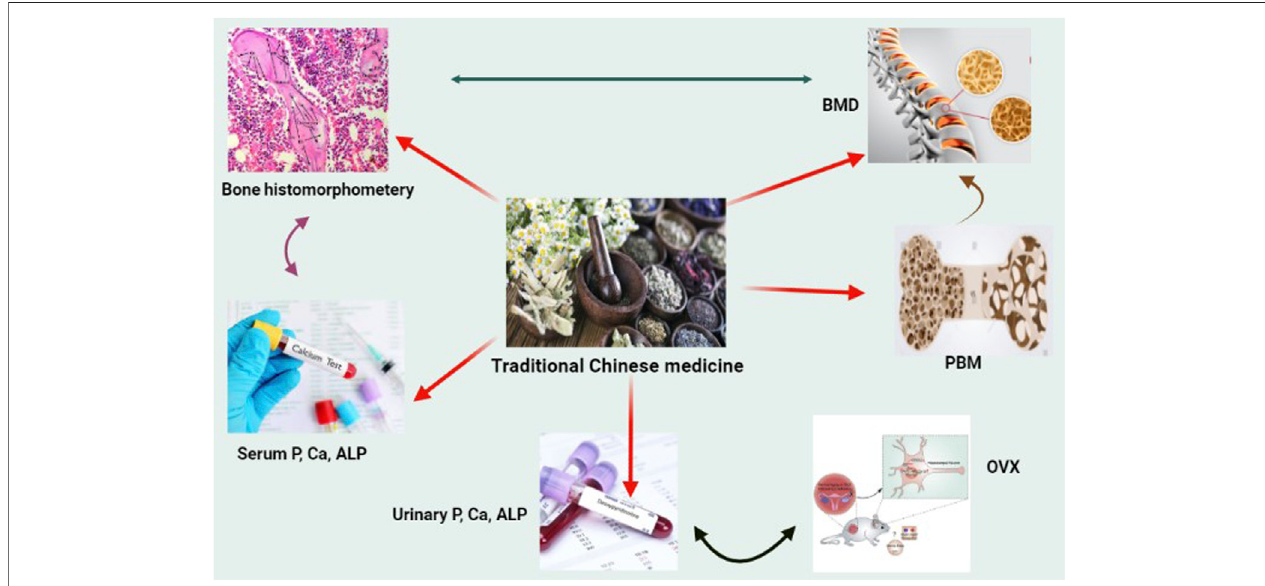
FIGURE 1 | Natural Chinese medicine ’ s therapeutic promise in the treatment of osteoporosis. When faced with the obstacles of oestrogen or androgen shortage, excessive hormone medicines, and weightlessness, bone quality will be severely harmed. Although various natural Chinese medications may be good choice for improving skeleton growth and preventing bone